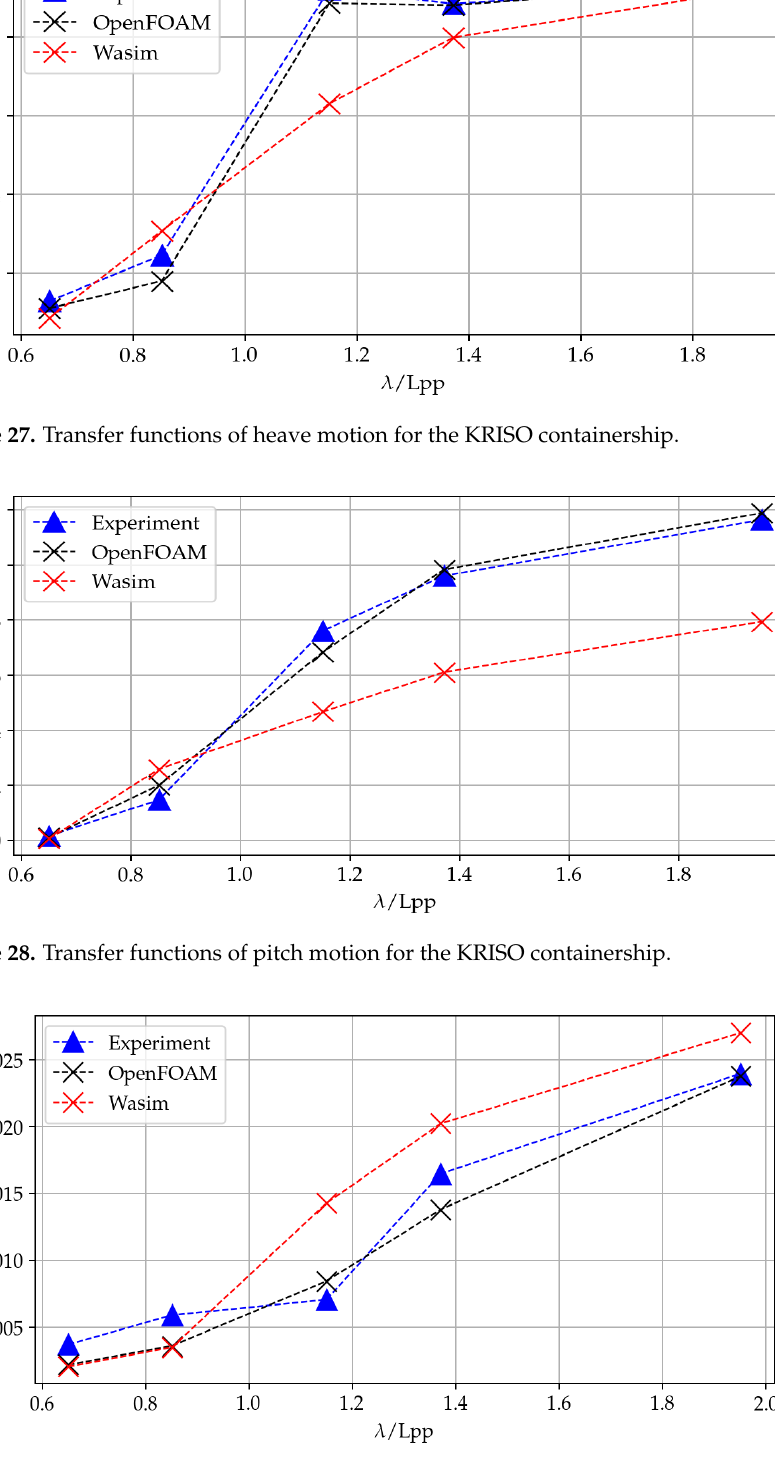
Figure 29. Total resistance coefficients for the KRISO containership.